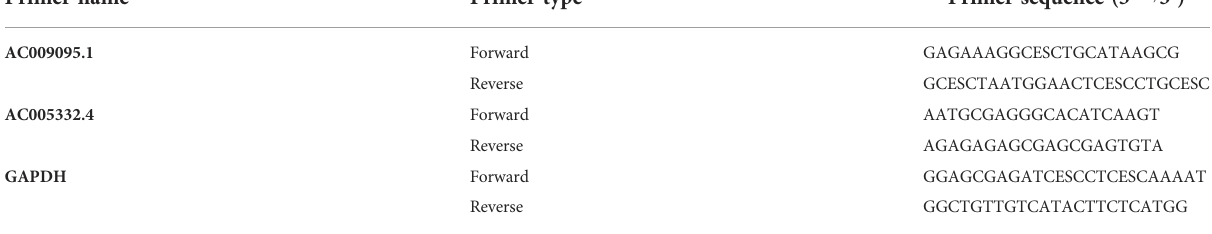
TABLE 1 PCR primers used in this